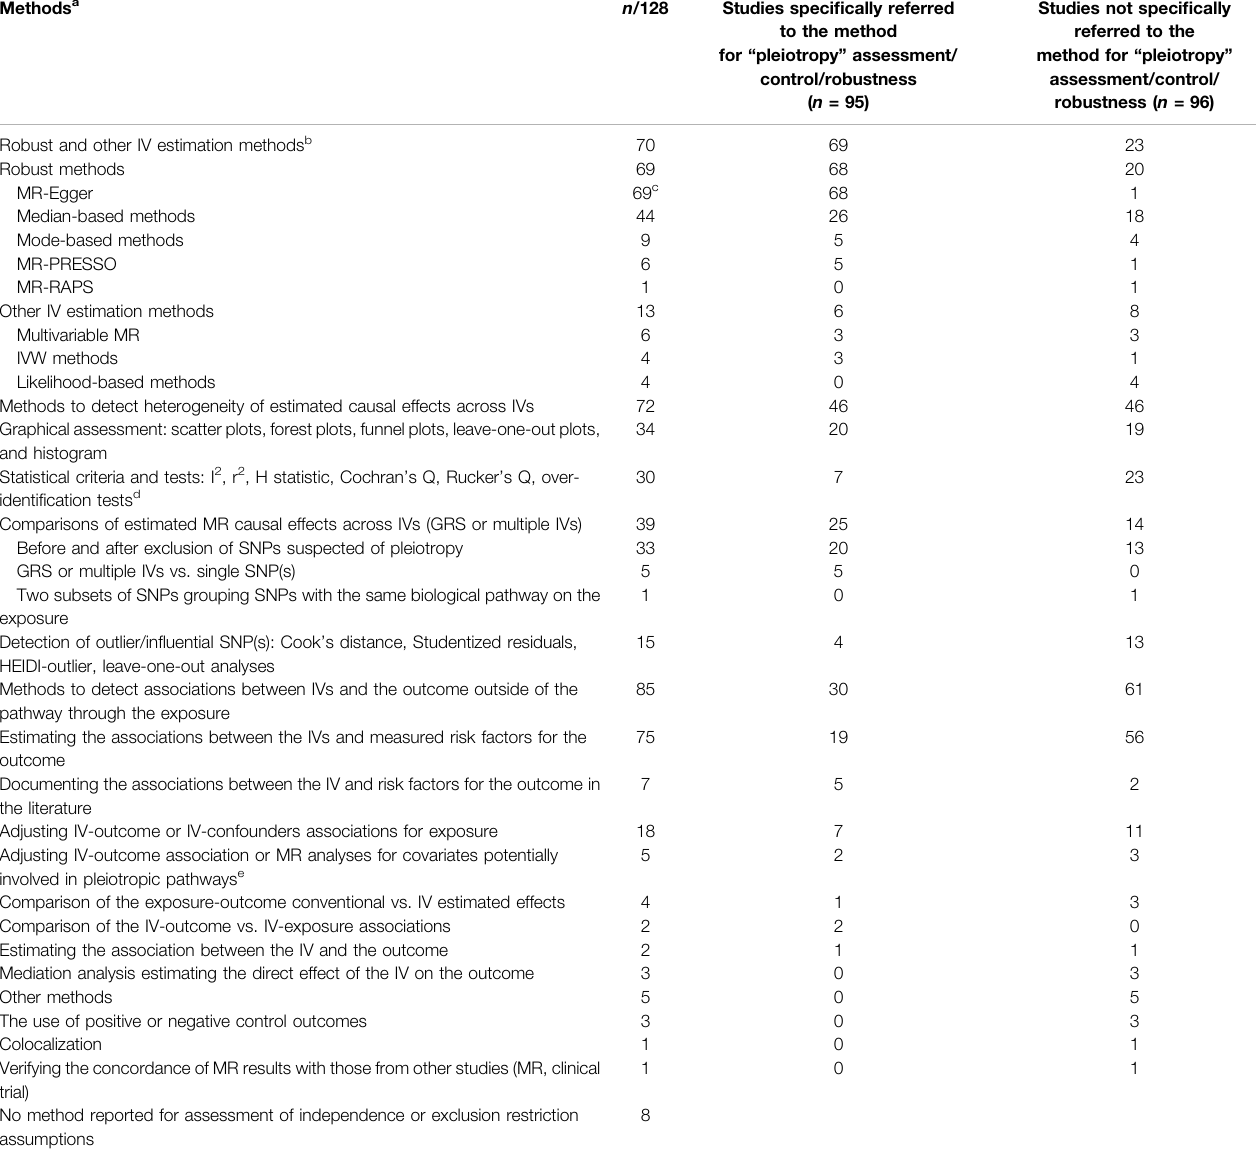
TABLE 3 | Methods cited for detection or accounting the violation of the independence and/or restriction exclusion